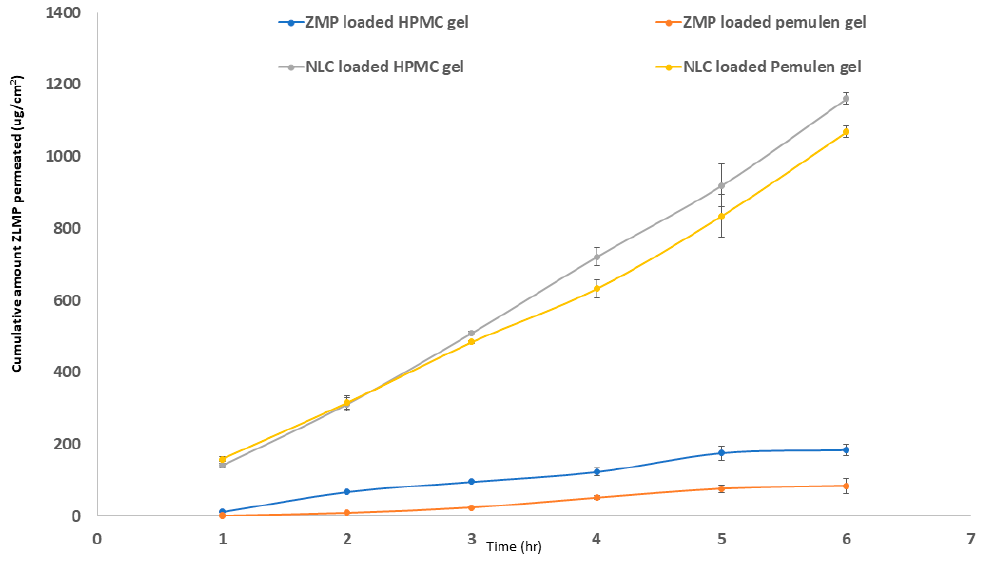
Figure 8. Mean cumulative zolmitriptan permeated from optimized NLCs (NLC9) compared to raw drug suspension, both loaded in HPMC and pemulen ® gels, across freshly excised shaved dorsal rat skin. Table 4. Ex vivo permeation parameters of optimized zolmitriptan-loaded NLC gels compared to zolmitriptan